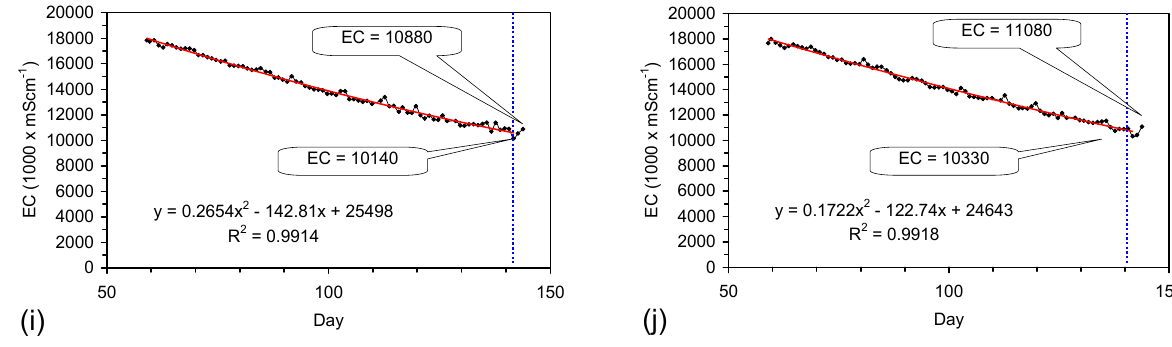
Figure D3. Feed Water EC = 17.660 mS·cm − 1 . ( a ) S2:T1; D = 0.0066; R 2 = 0.9321;